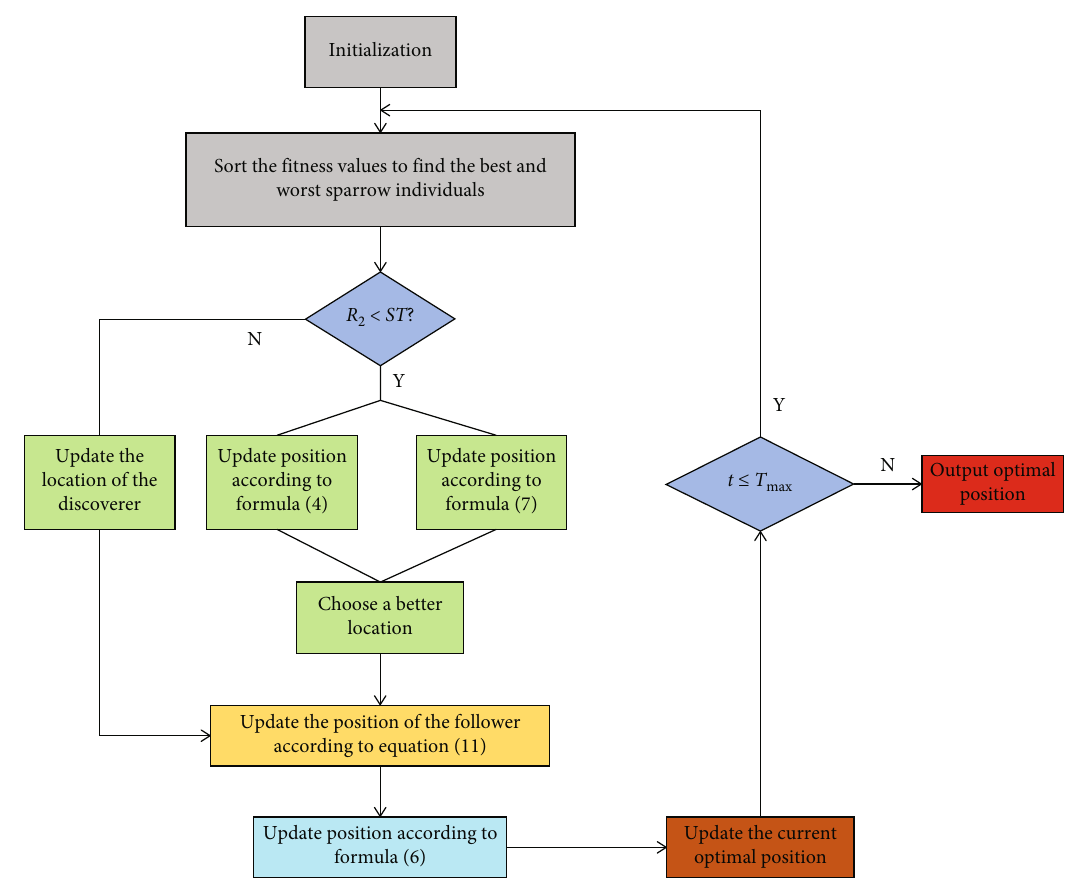
Figure 8: ISSA algorithm fl ow